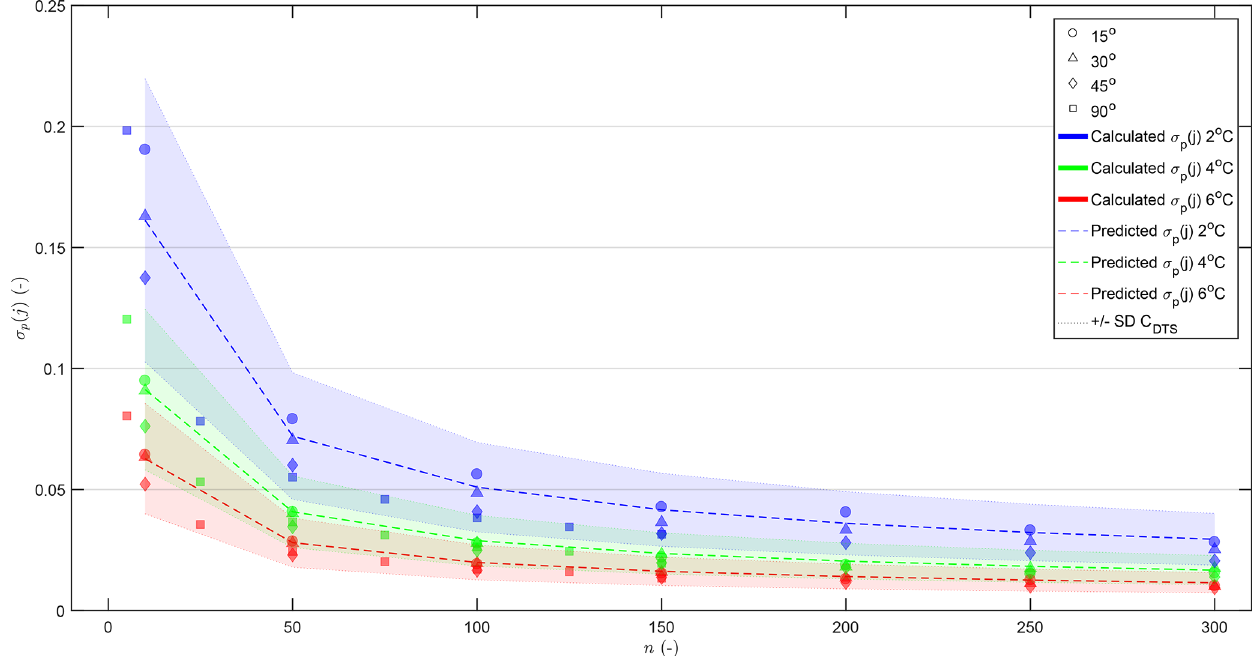
Figure 8. Verification of the precision function (Eq. 21). The predicted precision (dashed lines) is compared with the calculated precision from our experiment (Eq. 13). The dotted lines show the prediction with ± SD of C DTS